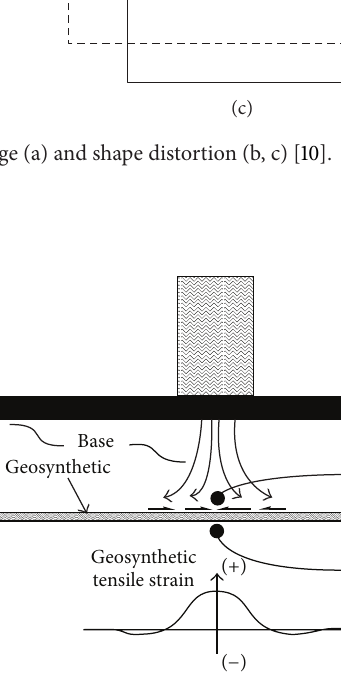
Figure 3: Schematic illustration of base reinforcement mechanism